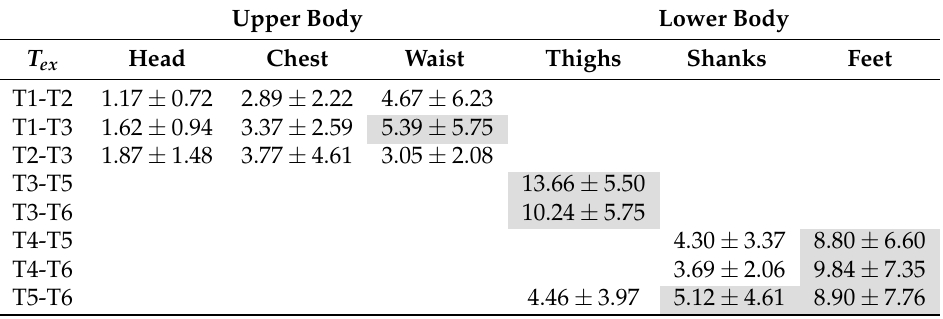
R matrices estimated from different tests. Table 11. Averaged error angle between 0 i Upper Body Lower